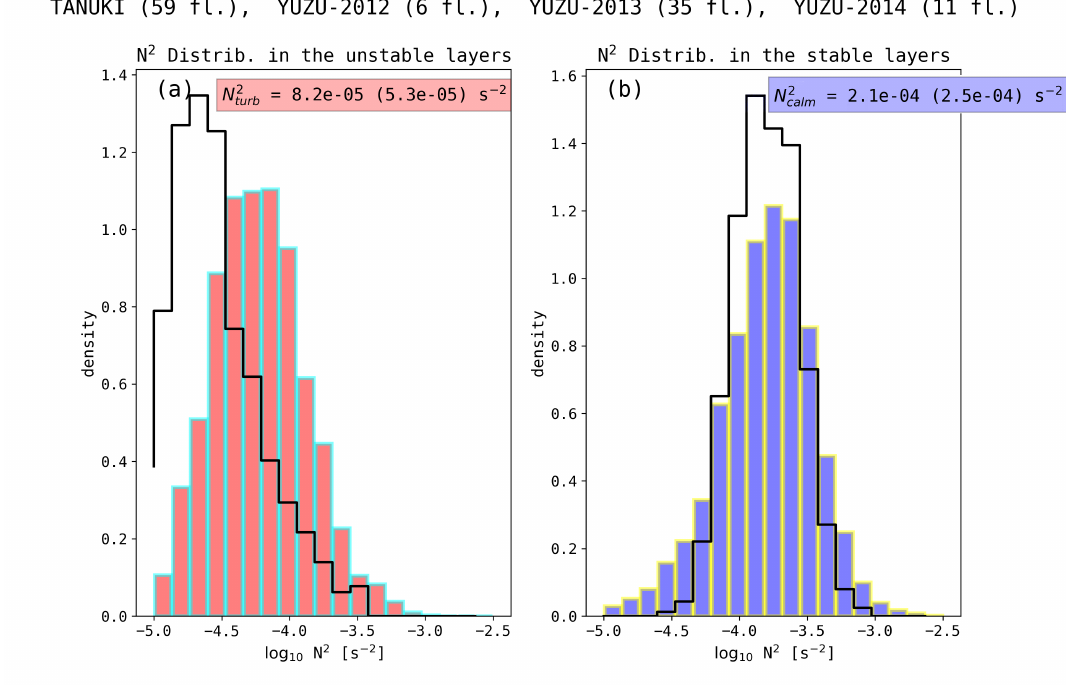
Figure 5. ( a ) Normalized histogram for the Brunt-Väisälä (BV) frequencies within turbulent layers. The black stair-like curve shows the histogram of the layers selected for the spectral analysis, i.e., thicker than 200 m from the low noise profiles. The average BV frequencies are indicated in the colored box, the averages for the thickest and low noise layers are shown between the parentheses. ( b ) Same as ( a ) but for the stably stratified